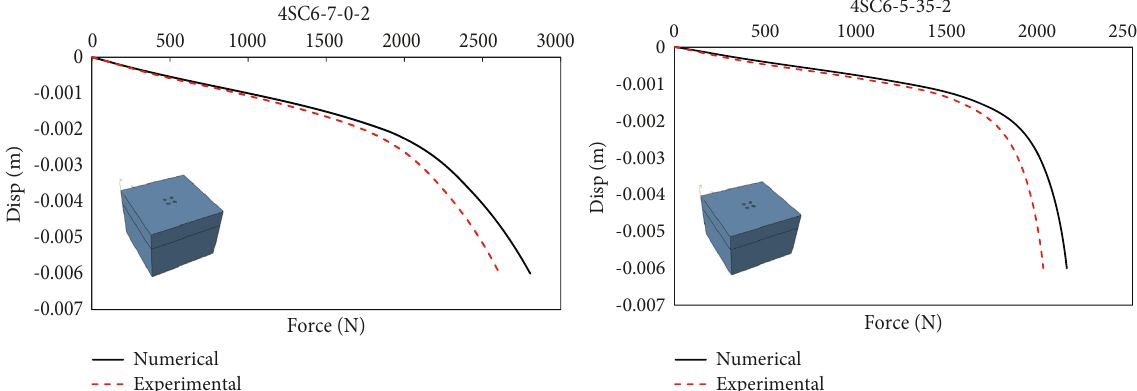
Figure 8: Force-displacement diagrams related to 4SC6-5-35-2 and 4SC6-7-0-2 models in both numerical and laboratory modes.